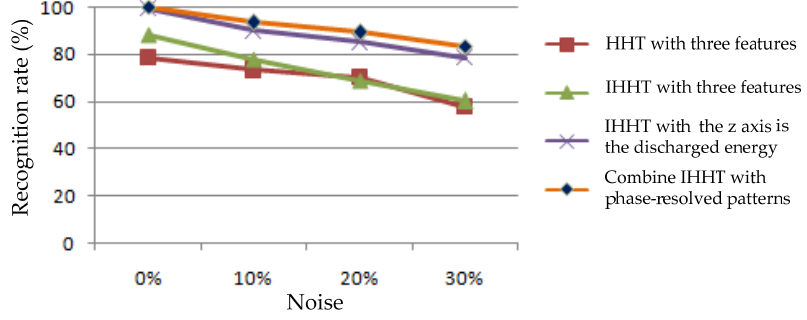
Figure 17. Mean identification results for various preprocessing approaches.